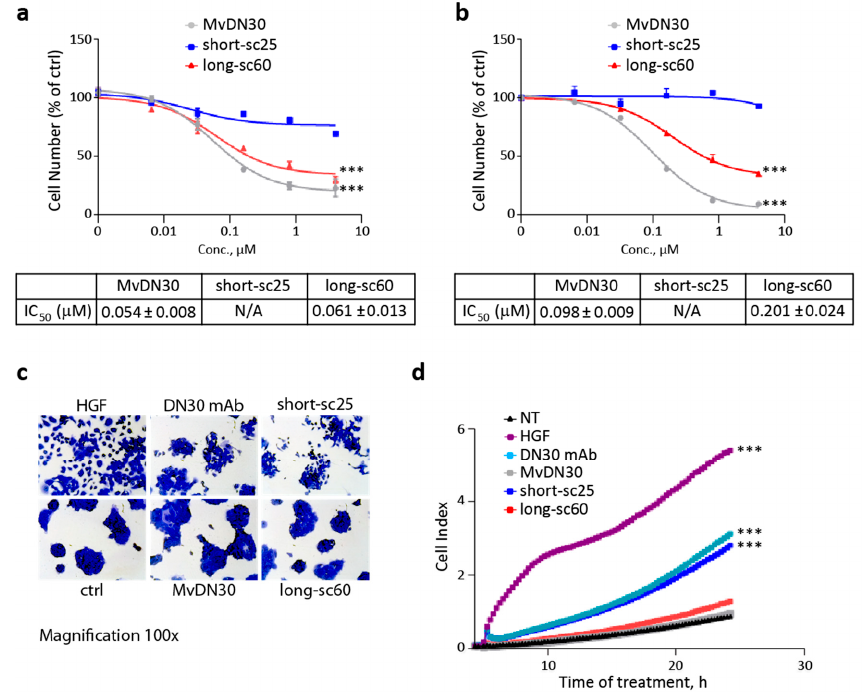
Figure 4. Long-sc60 inhibits MET -addicted cancer cell growth while short-sc25 induces cancer cell scattering. Growth of MET -addicted ( a ) SNU-5 and ( b ) EBC-1 cancer cells treated with increasing concentrations of the single-chain Fabs (0–5 µM) for 72 h. MvDN30 was included in the assay as reference. Graphs represent the percentage of living cells with respect to untreated cells. Samples are in triplicate; bars represent standard deviations. Scattering of human pancreatic adenocarcinoma (HPAF-II) cells in response to treatment with single-chain Fabs (100 nM) monitored ( c ) at end-point or ( d ) in real time using the X-CELLigence Real-Time Cell Analyzer (RTCA) device and expressed as normalized cell index. HGF (5 ng/mL), DN30 mAb (100 nM), and MvDN30 (100 nM) were included in the assay as references. NT: non-treated cells. Pictures and data reported in the plots are representative of at least three independent experiments. *** p < 0.001 t-test of treated versus untreated cells at the end of the